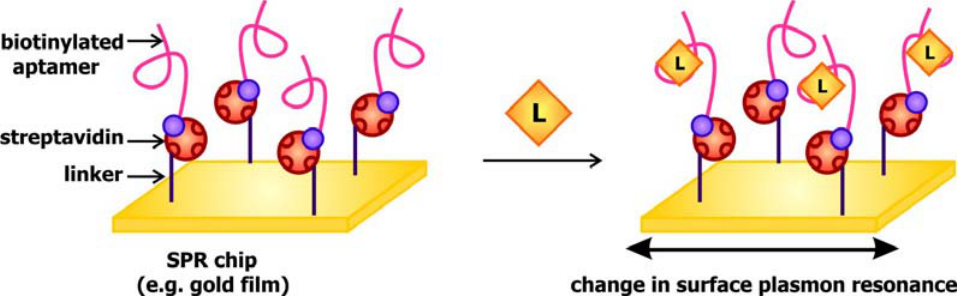
Figure 5. Design of aptamer-based biosensors that signal by surface plasmon resonance (SPR) [45, 46]. Ligand binding to this sensor may be detected by monitoring the change in